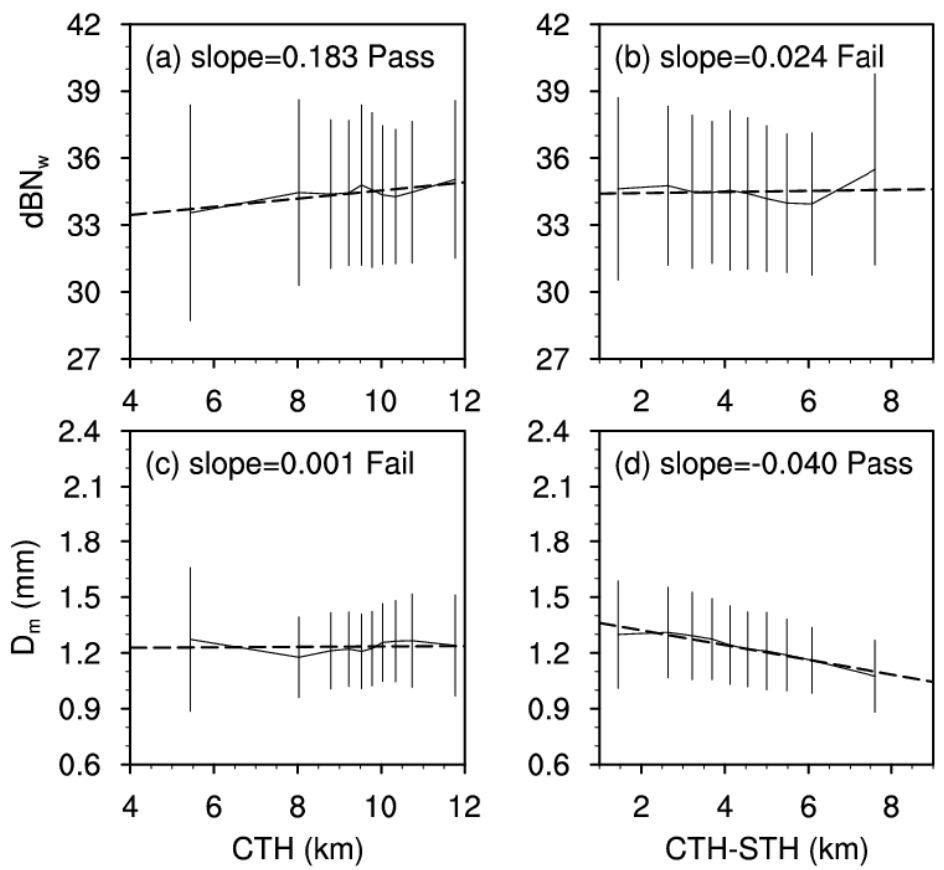
Figure 9. Relationship of ( a , c ) CTH and ( b , d ) CTH-STH with ( a , b ) dBN w and ( c , d ) D m for 2020-TC. Bars represent the standard deviation; the dashed line is the line of best fit for 10 equal-sample points; the panel lettering of each sub-figure is followed by the slope of the line of best fit and whether it passes the 95% significance test.